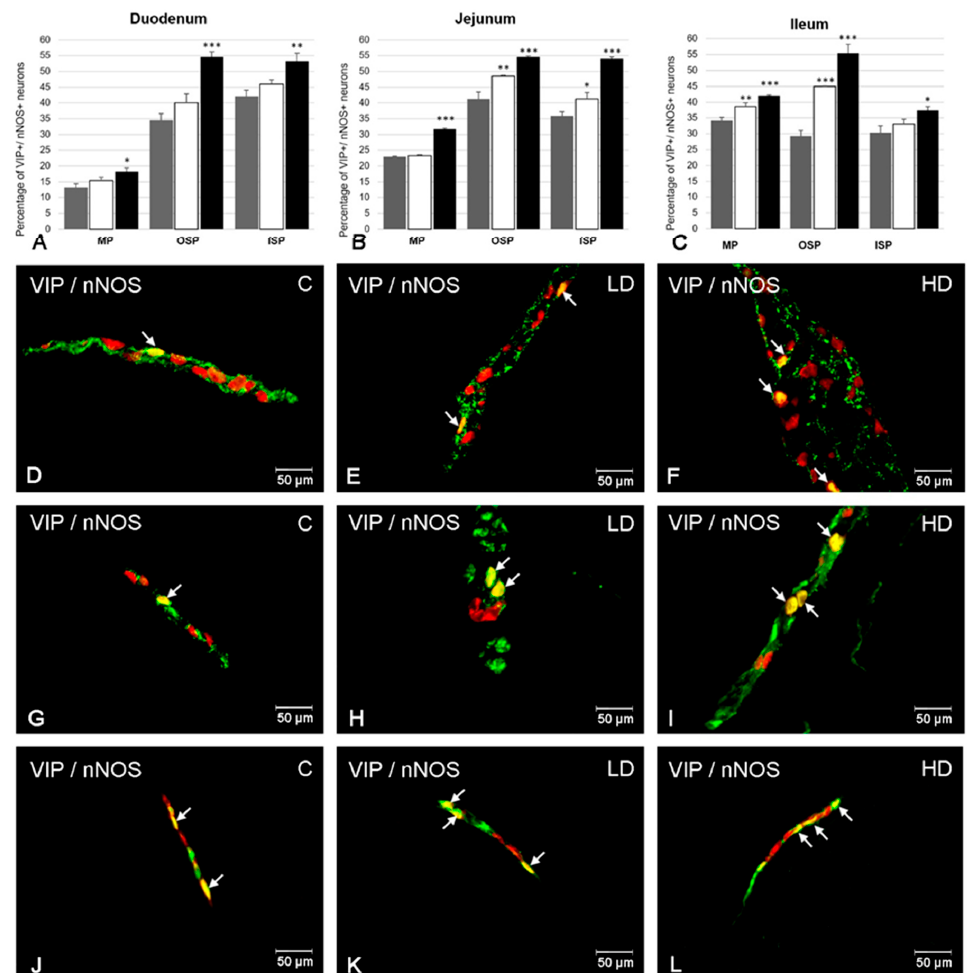
Figure 2. The ratio of co-localization of VIP with nNOS in intramural neurons in each part of the porcine small intestine (duodenum, jejunum and ileum) in control animals (grey bars), after low (white bars) and high doses (black bars) of acrylamide supplementation ( A – C ) and the most representative images showing VIP-LI neurons simultaneously immunoreactive to nNOS in animals from control ( D , G , J ), LD ( E , H , K ) and HD ( F , I , L ) group. ( A ) Mean ( ± SEM) percentage of VIP +/ nNOS + neurons in the myenteric plexus (MP), outer submucous plexus (OSP), and inner submucous plexus (ISP) within the porcine duodenum; ( B ) Mean ( ± SEM) percentage of VIP +/ nNOS + neurons in the myenteric plexus (MP), outer submucous plexus (OSP), and inner submucous plexus (ISP) within the porcine jejunum; ( C ) Mean ( ± SEM) percentage of VIP +/ nNOS + neurons in the myenteric plexus (MP), outer submucous plexus (OSP), and inner submucous plexus (ISP) within the porcine ileum; ( D ) VIP +/ nNOS + neurons in the myenteric plexus of the porcine ileum in animals from control group; ( E ) VIP +/ nNOS + neurons in the myenteric plexus (MP) of the porcine ileum in animals from LD group; ( F ) VIP +/ nNOS + neurons in the myenteric plexus (MP) of the porcine ileum in animals from HD group; ( G ) VIP +/ nNOS + neurons in the outer submucous plexus (OSP) of the porcine jejunum in animals from control group; ( H ) VIP +/ nNOS + neurons in the outer submucous plexus (OSP) of the porcine jejunum in animals from LD group; ( I ) VIP +/ nNOS + neurons in the outer submucous plexus (OSP) of the porcine jejunum in animals from HD group; ( J ) VIP +/ nNOS + neurons in the inner submucous plexus (ISP) of the porcine jejunum in animals from control group; ( K ) VIP +/ nNOS + neurons in the inner submucous plexus (ISP) of the porcine jejunum in animals from LD group; ( L ) VIP +/ nNOS + neurons in the inner submucous plexus (ISP) of the porcine jejunum in animals from control group. All images were created by digital superimposition of two color channels (green for VIP and red for nNOS). Intramural neurons immunopositive to VIP and nNOS are indicated with arrows. Significant di ff erences were assessed with one-way analysis of variance (ANOVA) with Dunnett’s test (* p < 0.05, ** p < 0.01, *** p <